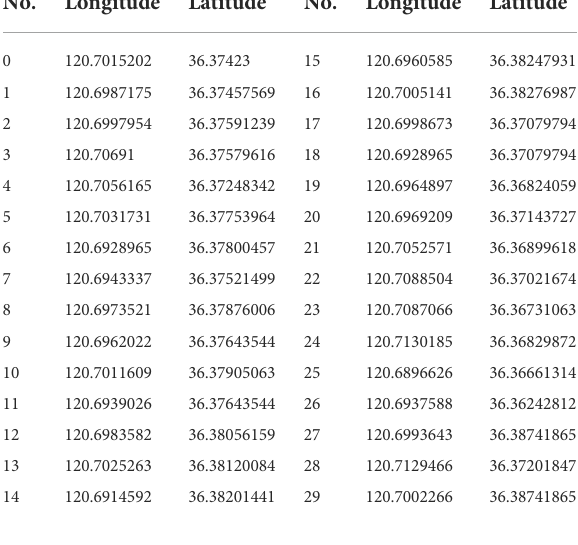
TABLE 3 Sensor coordinate dataset in